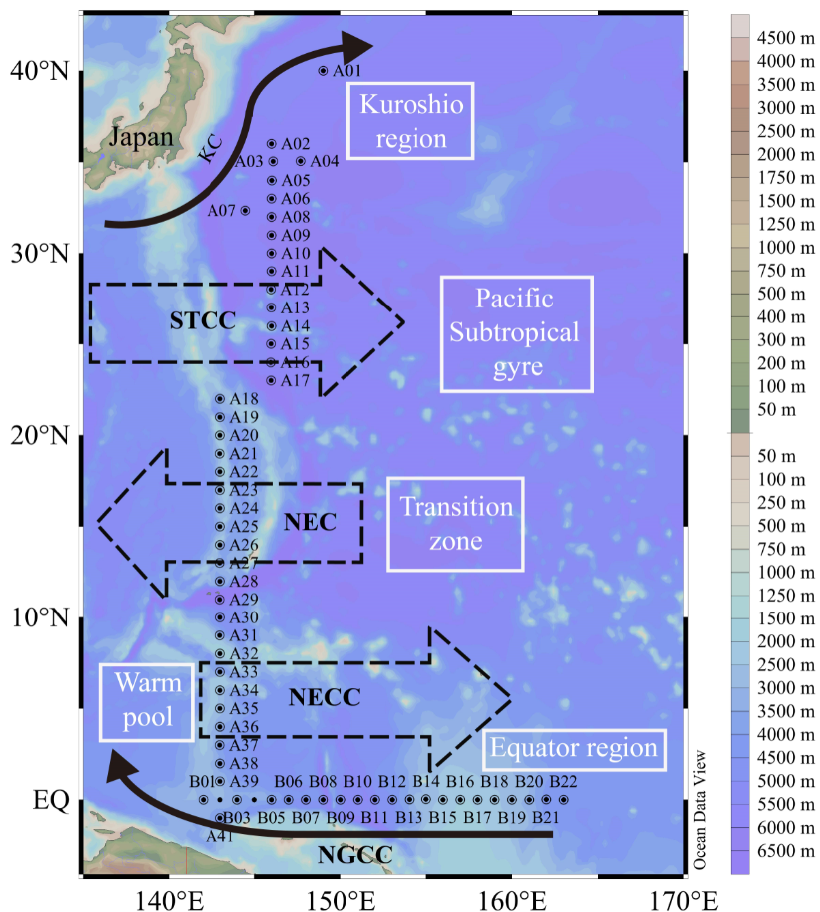
Figure 1. Study area and locations of the sampling stations in the WPO. Map of the WPO shows the major geographic names and the surface currents, including the Kuroshio Current (KC), the Subtropical Counter Current (STCC), the North Equatorial Current (NEC), the Northern Equatorial Counter Current (NECC), and the New Guinea Coastal Current (NGCC) [22,23].